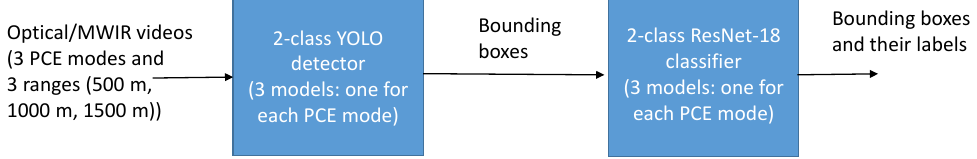
Figure 2. The relationship between you only look once (YOLO) and residual network (ResNet) for human target detection and confirmation.